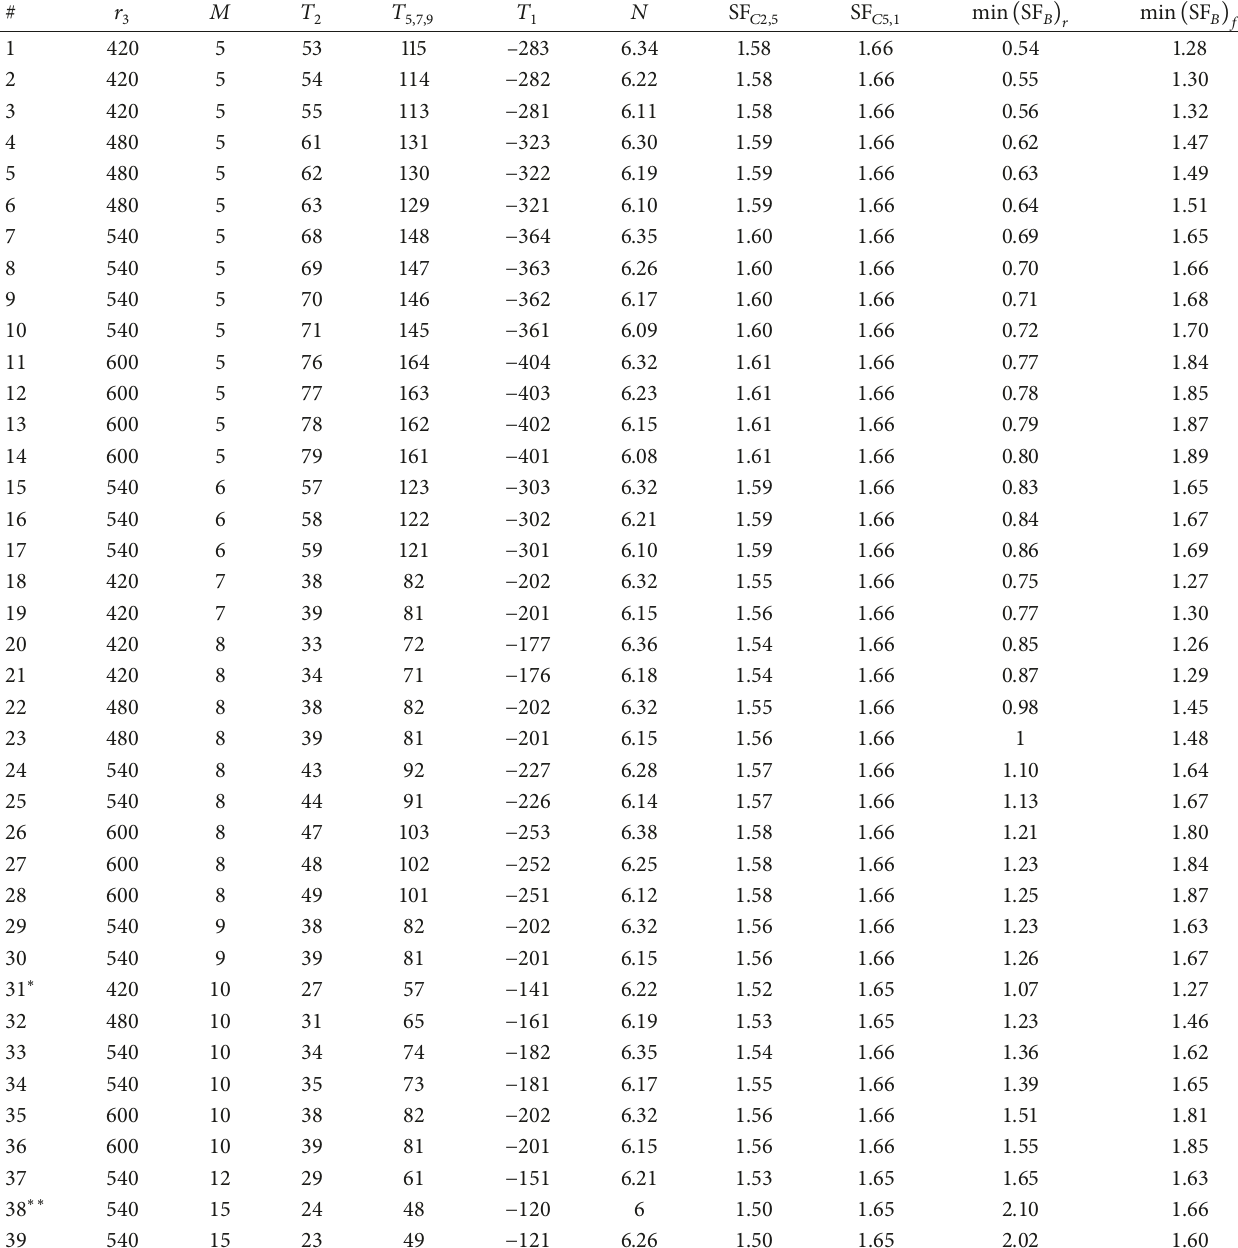
Table 5: Working designs of planetary